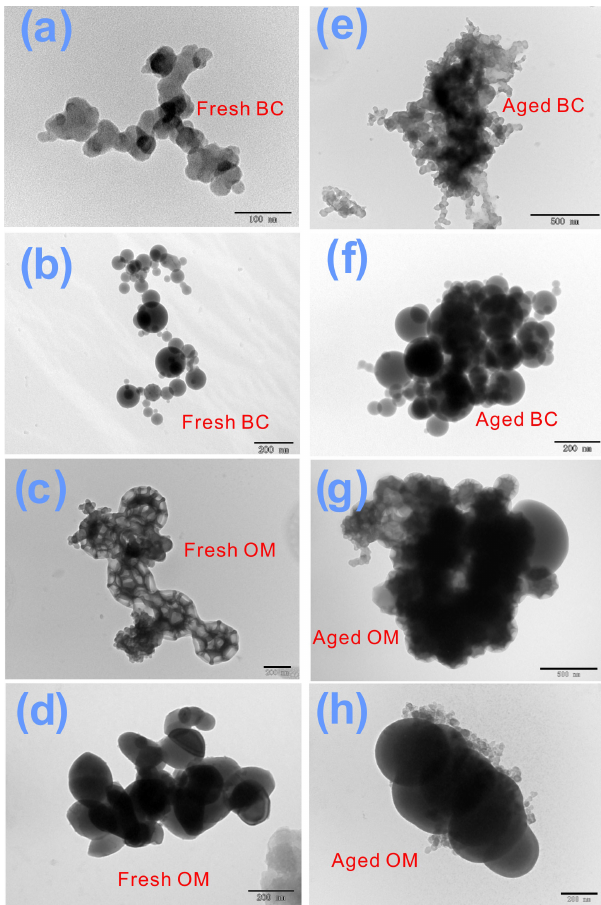
Figure 4. Structural change during the aging of individual black carbon / organic matter particles when deposited from the atmo- sphere onto snow and ice surfaces. Panels (a) – (d) represent the atmosphere, while (e) – (h) show the condition of the glacier– snowpack.